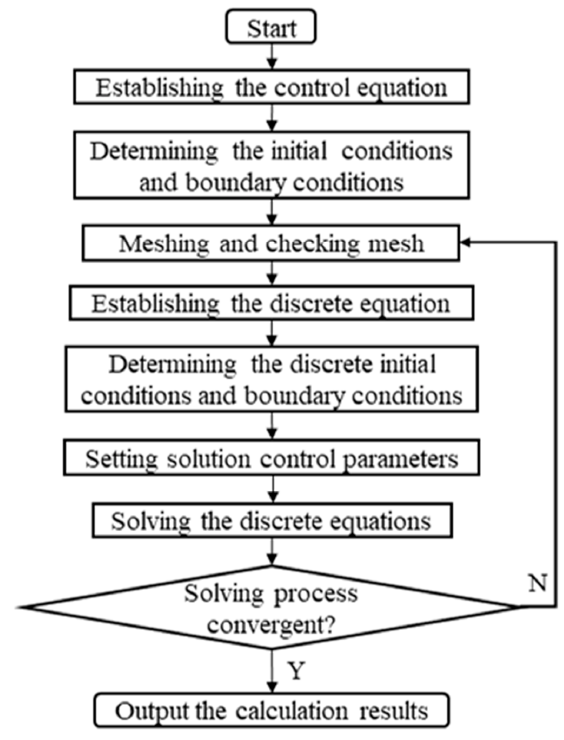
Figure 5. Flow chart of computational fluid dynamics (CFD)